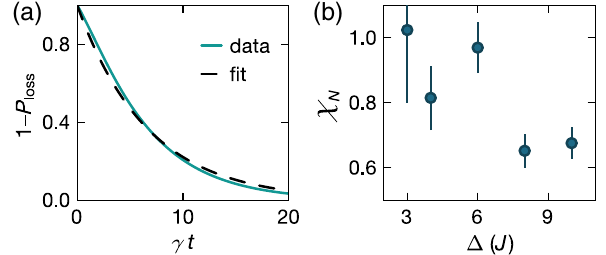
FIG. 8. Atom number loss. (a) Fraction of atoms remaining in the ground or first excited bands vs time. The dashed line shows an exponential fit to extract the time scale. (b) Noninteracting atom number susceptibilities. Error bars show the uncertainty of the extracted value, including both the fitting procedure and the error in the initial data.